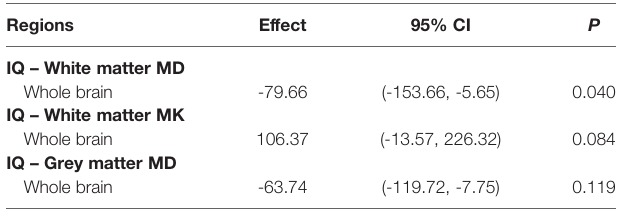
TABLE 2A | Multiple regression analysis of the relationships between IQ and diffusion metrics of the whole brain. Regions